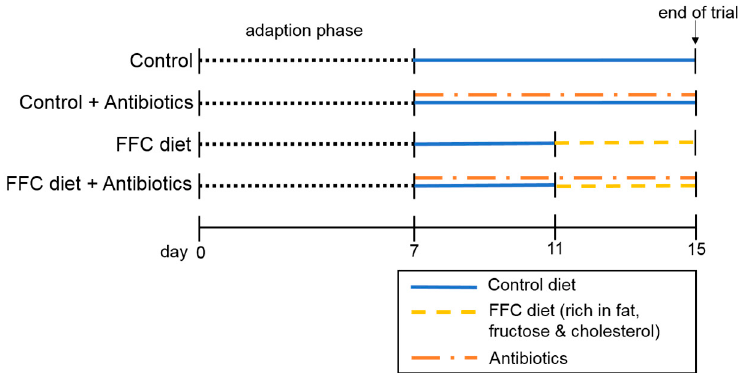
Figure 1. Summary of study design. After adapting mice for 7 days to the intake of a liquid diet followed by 4 days of pretreatment with the non-resorbable antibiotics (92 mg polymyxin B/kg body weight/day and 216 mg neomycin/kg body weight/day) or vehicle (=water) added to the liquid control diet, mice ( n = 6–8/group) were either fed the liquid control diet or a diet rich in fat, fructose & cholesterol (FFC) ± antibiotics for another 4 days.